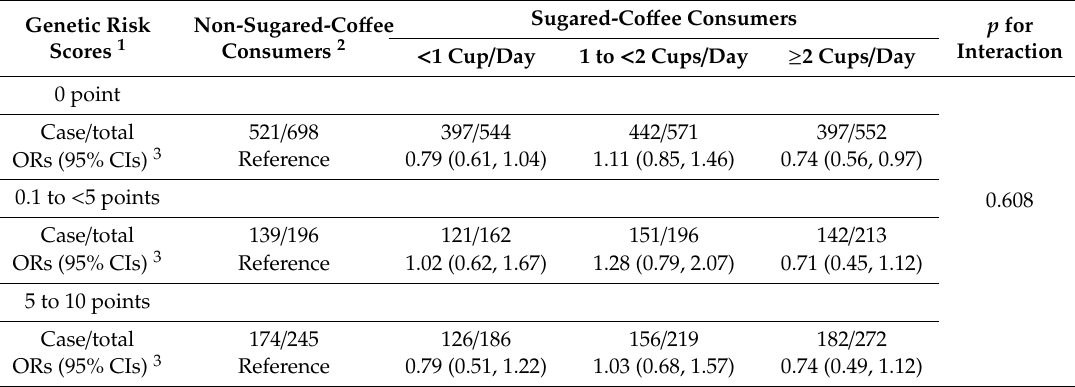
Table 6. Multivariate-adjusted ORs and 95% CIs for the risk of prediabetes and type 2 diabetes combined by genetic risk scores according to sugared co ff ee